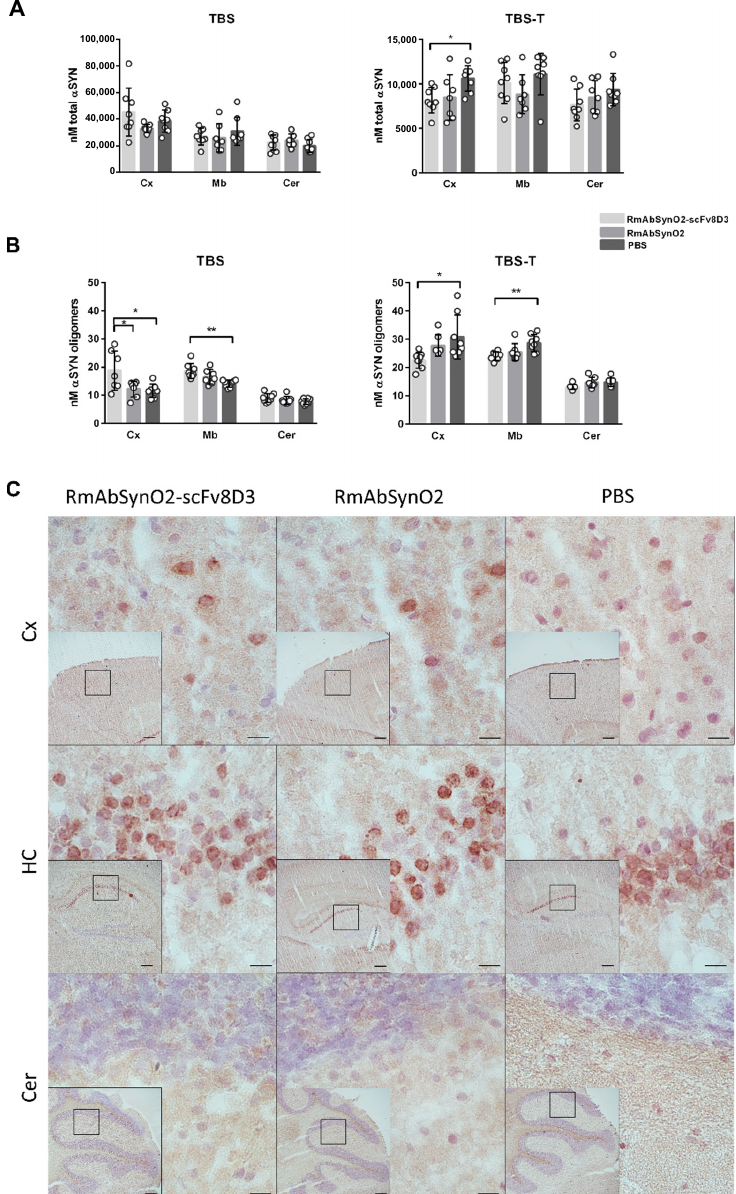
Figure 4 . ( A ) Levels of total α SYN in TBS and TBS-T brain extracts measured with MJFR1/Syn-1 enzyme-linked immunosorbent assay (ELISA) measuring all forms of α SYN. No differences in total α SYN in the cortex (Cx), midbrain (Mb), and cerebellum (Cer). Reduced total α SYN in Cx in the TBS-T fraction in mice treated with RmAbSynO2-scFv8D3 in comparison with the PBS group. ( B ) Oligomeric α SYN levels in TBS and TBS-T extracts measured with a homogenous MJFR-14-6-4-2 ELISA. Oligomeric α SYN in the TBS fraction was increased in Cx in the RmAbSynO2-scFv8D3 group in comparison with both the RmAbSynO2- and the PBS control groups and in Mb compared to the PBS group. Oligomeric α SYN levels in the TBS-T fraction were instead decreased in Cx and Mb in the RmAbSynO2-scFv8D3 group compared to PBS controls, while Cer α SYN levels were unchanged. ( C ) Representative images of 20 µ m cryosections stained for Iba1 in Cx, hippocampus (HC), and Cer at 60 × magnification, with 4 × magnifications embedded with squares representing the magnified area. No differences in immunoreactivity were noted between the treatment groups. All values are presented as means ± SD, with a one-way analysis of variance followed by Sidak’s multiple comparison test. * p < 0.05, ** p < 0.005. Scale bars: 200 µ m in embedded images, 10 µ m in magnified